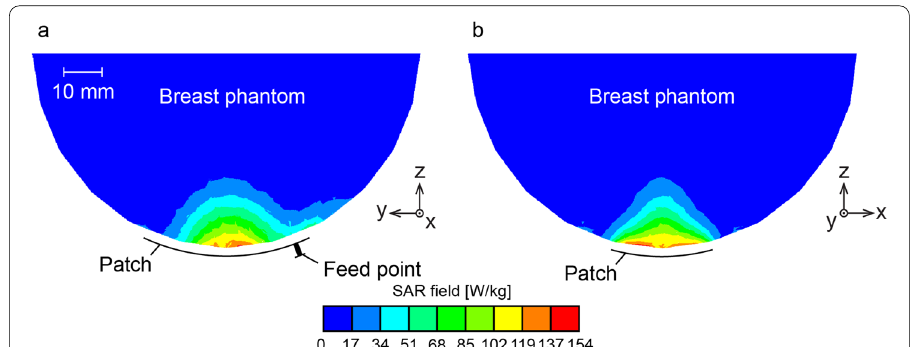
Fig. 9 Cross sections of the SAR distribution in the tissue simulated in HFSS